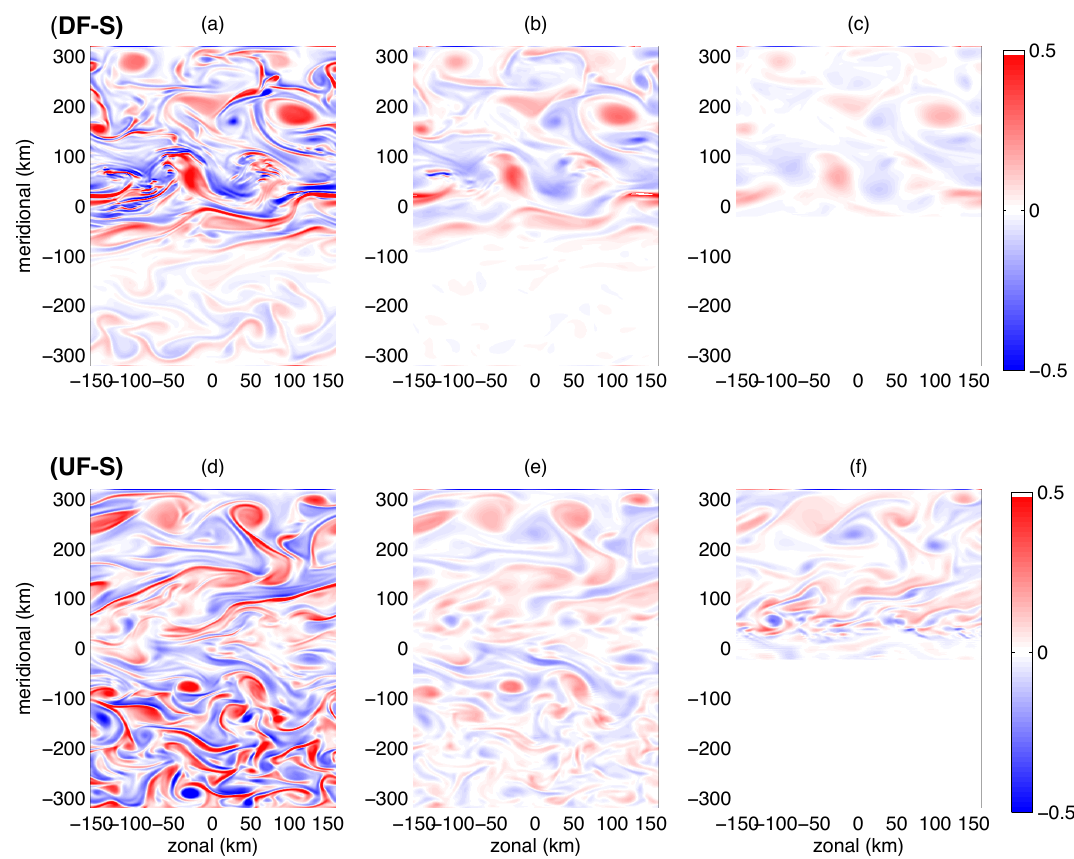
Figure 11. Vertical structure of Ro at day 900 for Experiment DF-S ( a – c ) and Experiment UF-S ( d – f ). Cross sections at 10 m, 150 m, and 300 m depth are shown. White areas in ( c , f ) are associated with topographic slope